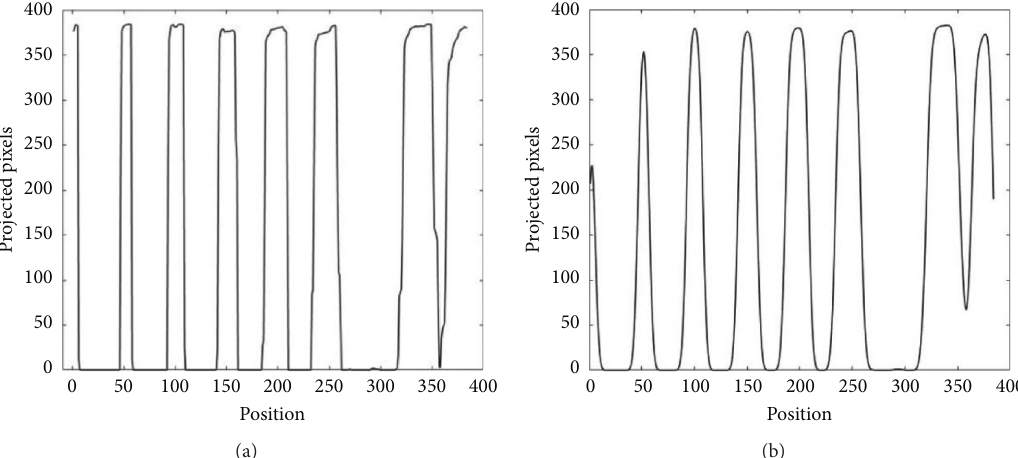
Figure 6: The projection curve and smoothing result of anti-glare panel: (a) one-dimensional projection of the image; (b) one-dimensional curve smoothing.